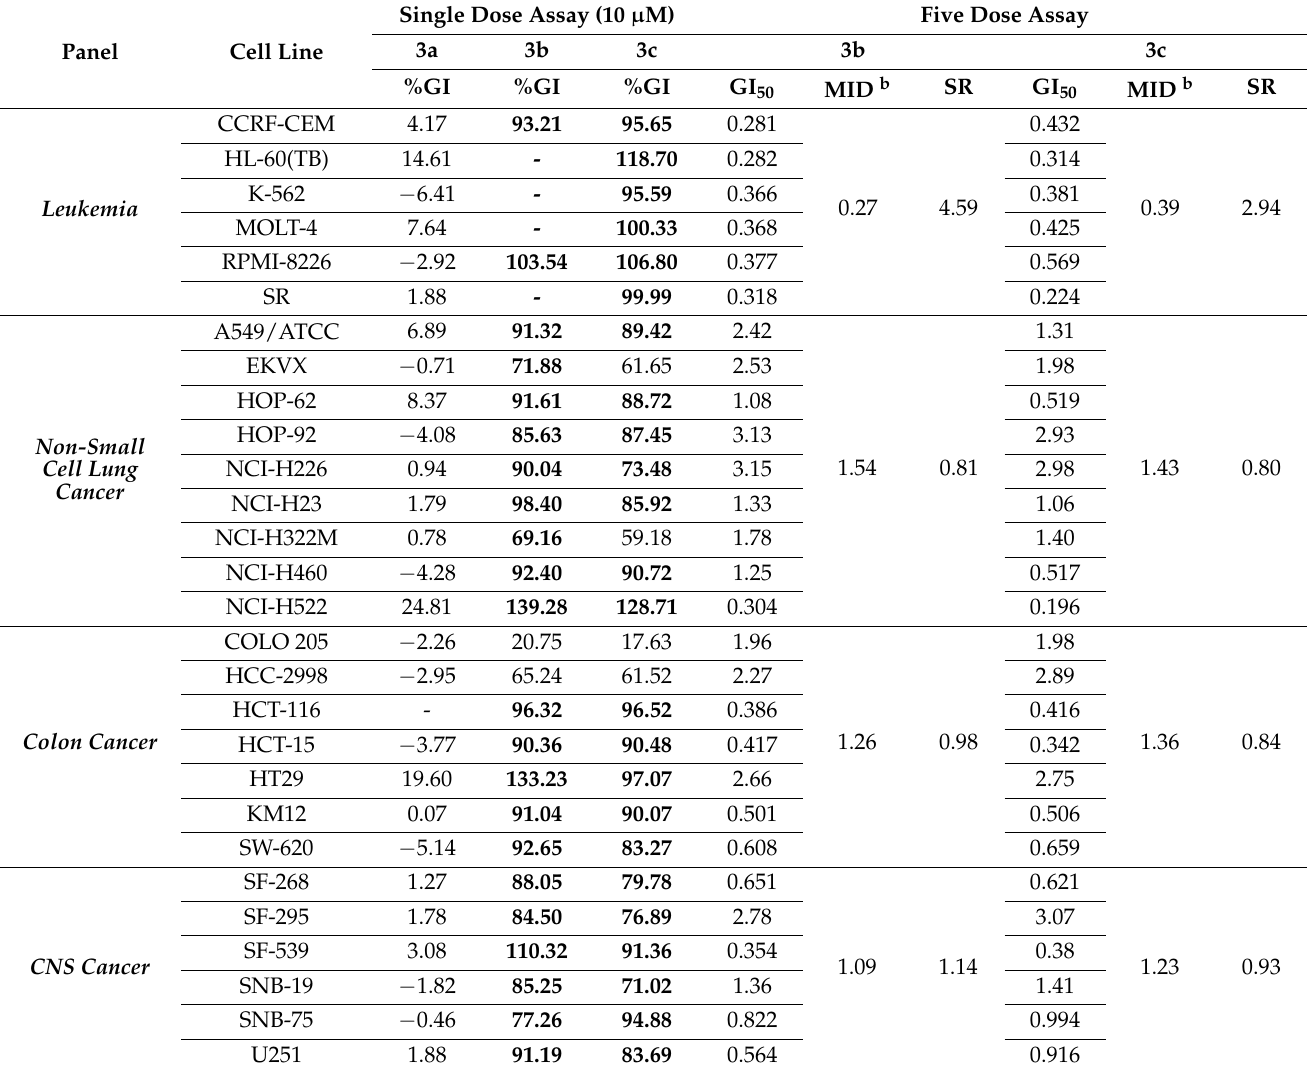
Table 3. 60 NCI cancer cell lines-based antiproliferative activity of curcumin analogues 3a–c in